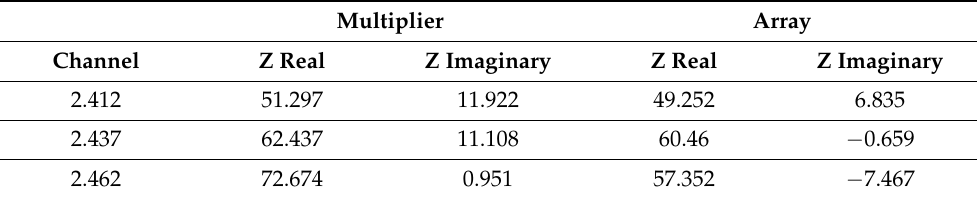
Table 5. 7 × multiplier and array impedance for WiFi Channels 1, 6, and 11.